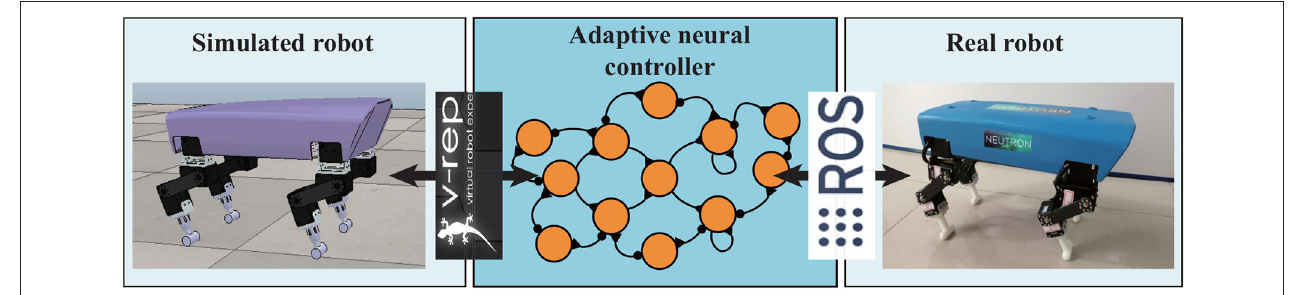
FIGURE 1 | System overview of Lilibot. The adaptive neural controller is implemented in ROS such that it can directly communicate with both the simulated robot in the V-REP simulation and the real robot. The simulated and real robots were consistently developed, such that the simulation demonstrates a good estimation of the actual performance. A video showing a comparison between the simulated and real robot behaviors can be seen at